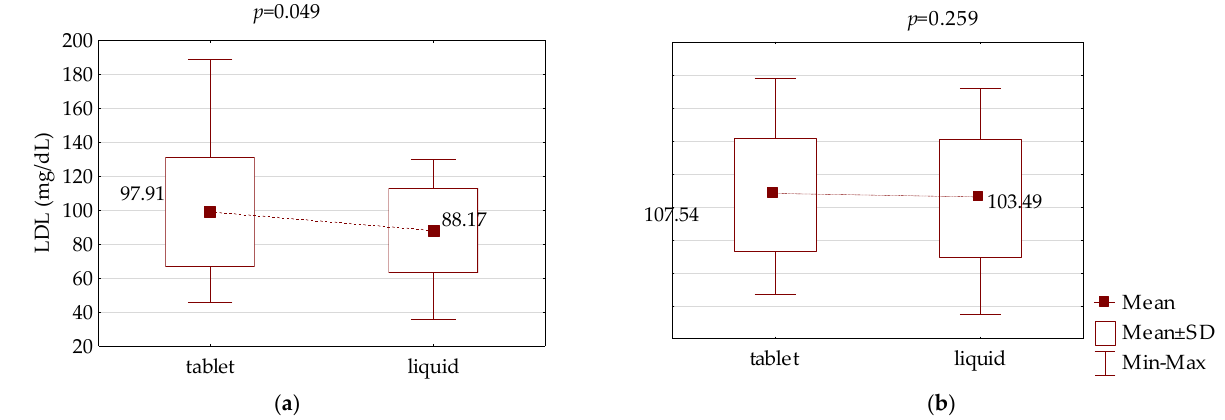
Figure 4. Comparison of SHBG serum concentration between LT4 therapy in tablet and liquid form in an equivalent dose in: ( a ) primary and ( b ) central hypothyroidism.